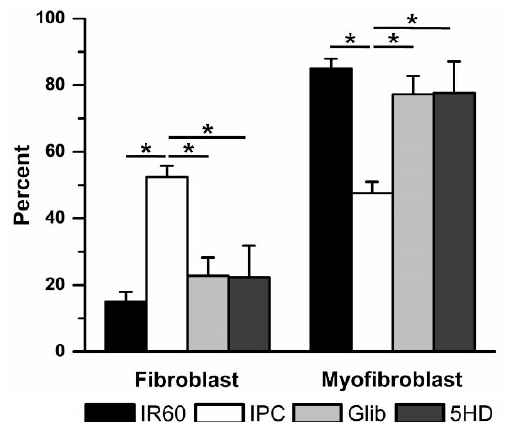
Figure 7. Ischemic preconditioning (IPC) was reduced by blocking K ATP channels with the non-specific K ATP blocker glibenclamide (Glib) and the mK ATP – selective K ATP blocker 5-hydroxydecanoate (5HD). Blocking K ATP channels with Glib (10 μ M) or 5HD (100 μ M) prevented IPC from reducing ischemia reperfusion (IR)-induced fibroblast to myofibroblast differentiation. * p < 0.05, comparisons indicated by the lines.